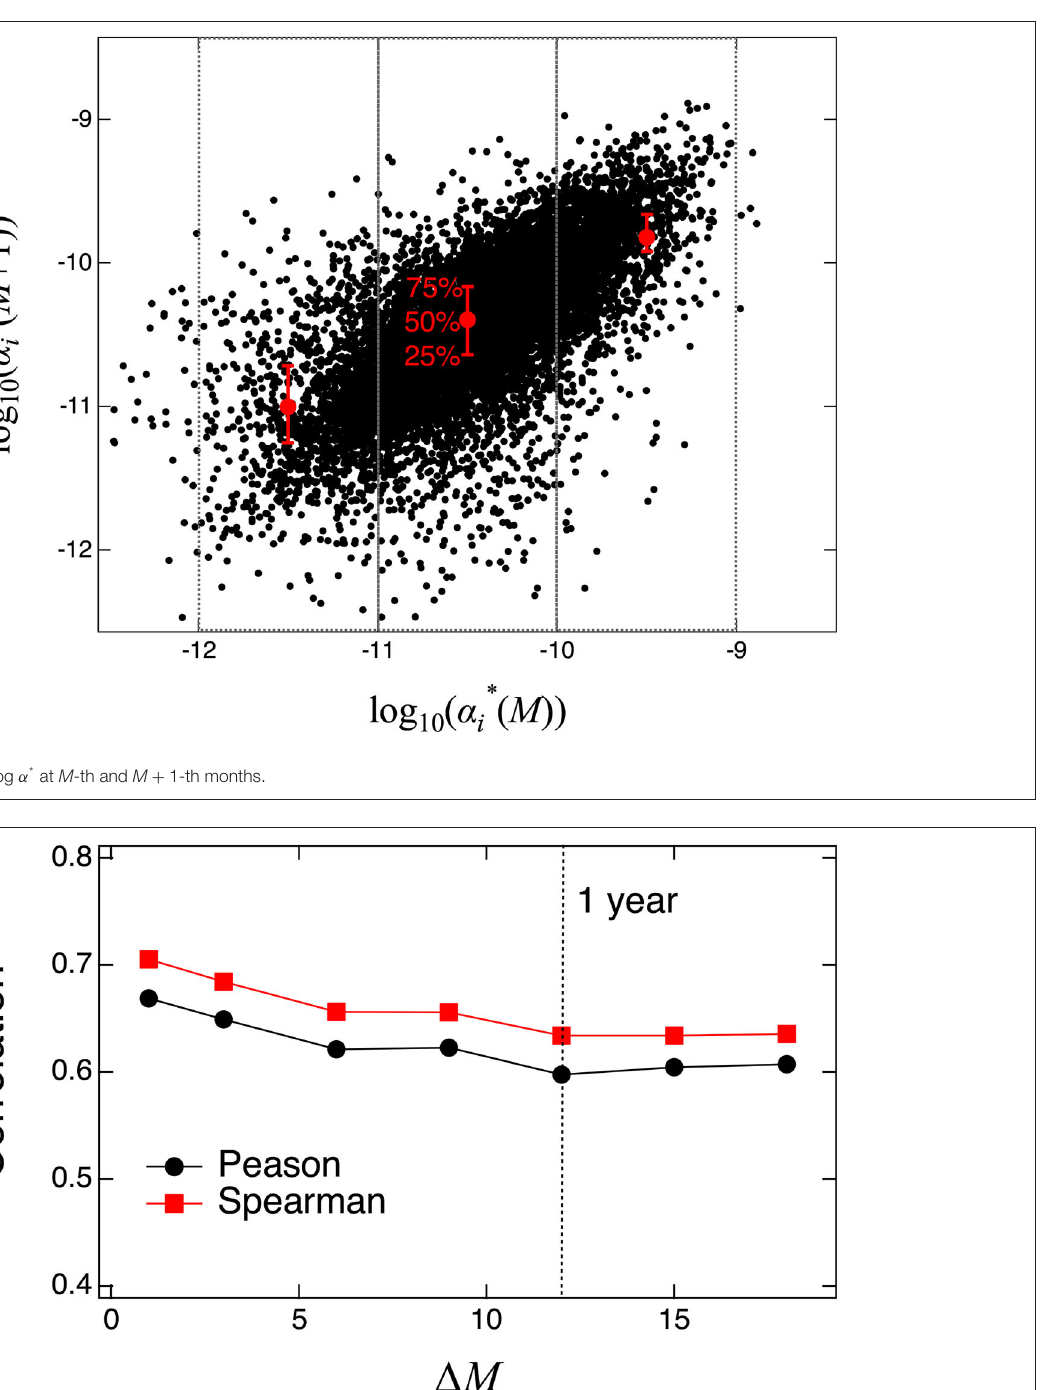
approximately 0.64 when 1 M = 18. The market impact, which does not change drastically, can be estimated using past market impact